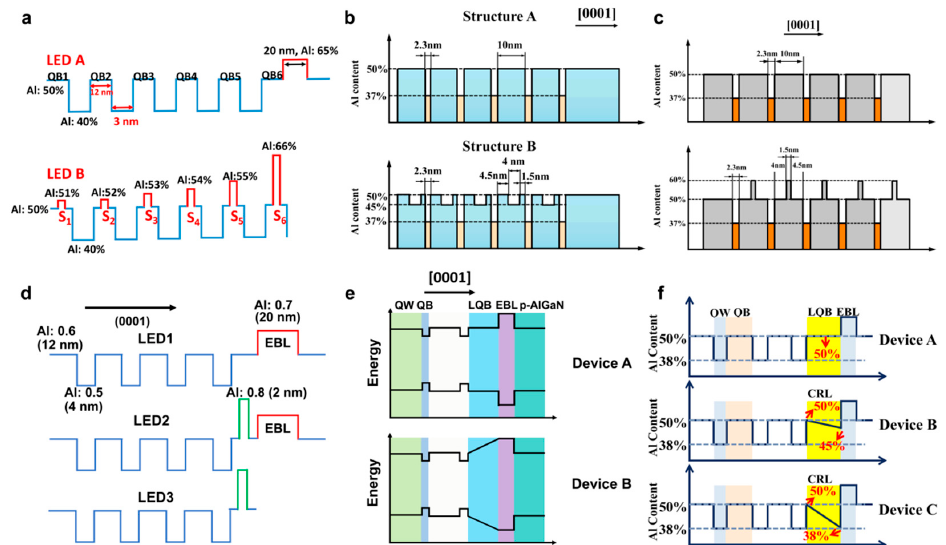
Figure 7. Conduction band diagrams of the active region of the DUV LED ( a ) without (LED A) and with (LED B) inserting thin layers in the QBs [90], ( b ) without (structure A) and with (structure B) asymmetrical concave QBs [91], ( c ) without (upper) and with (lower) delta-accelerating QBs [92], ( d ) without strip-in-a-barrier structure but EBL (LED 1), with strip-in-a-barrier structure and EBL (LED 2), with strip-in-a-barrier structure but EBL (LED 3) [93], ( e ) constant Al content (Device A) and gradually increasing Al content (Device B) LQB, [94] and ( f ) constant Al content (Device A) and gradually decreasing Al content (Device B and C) LQB [95].